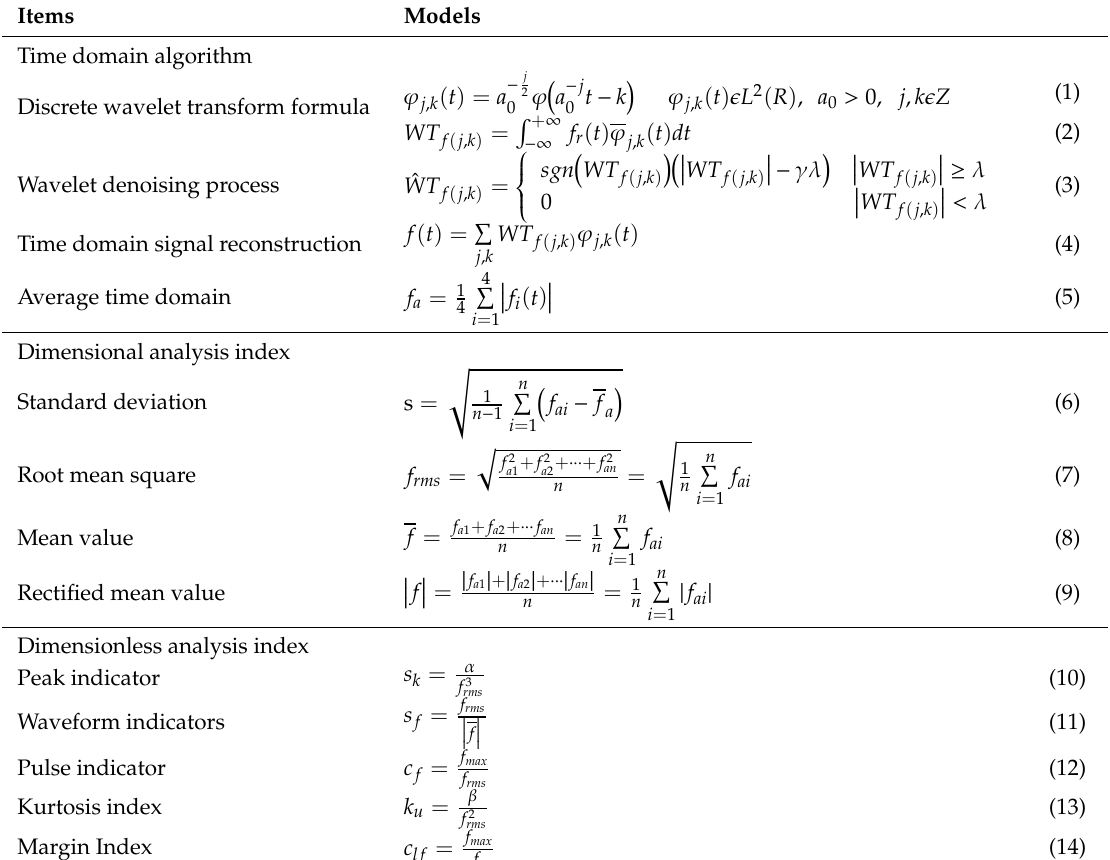
Table 3. Models for hydrocyclone fault